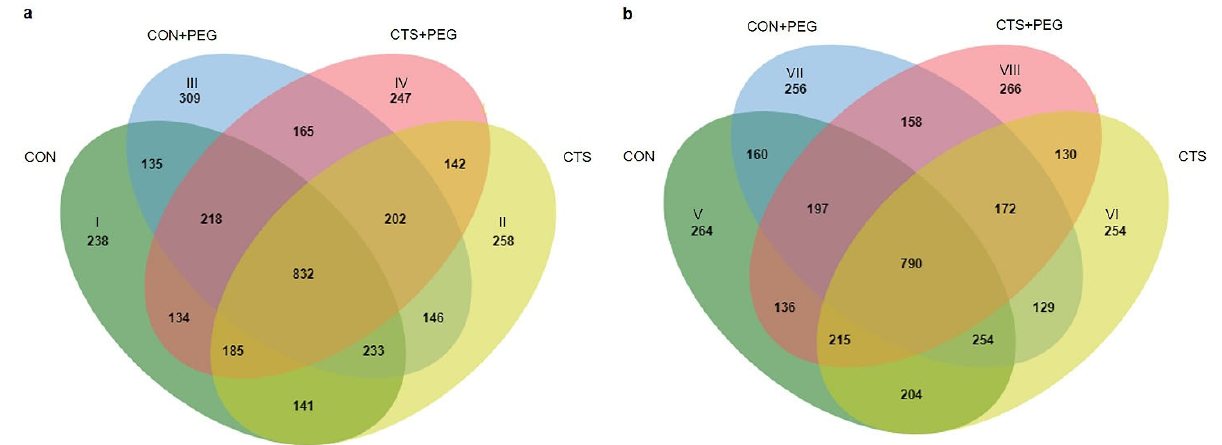
( b ) cultivars. Differentially expressed phosphoproteins (DEPs) were retrieved among the four differ- ent treatment groups. CON (I and V), CTS (II and VI), CON + PEG (III and VII), and CTS + PEG (IV and